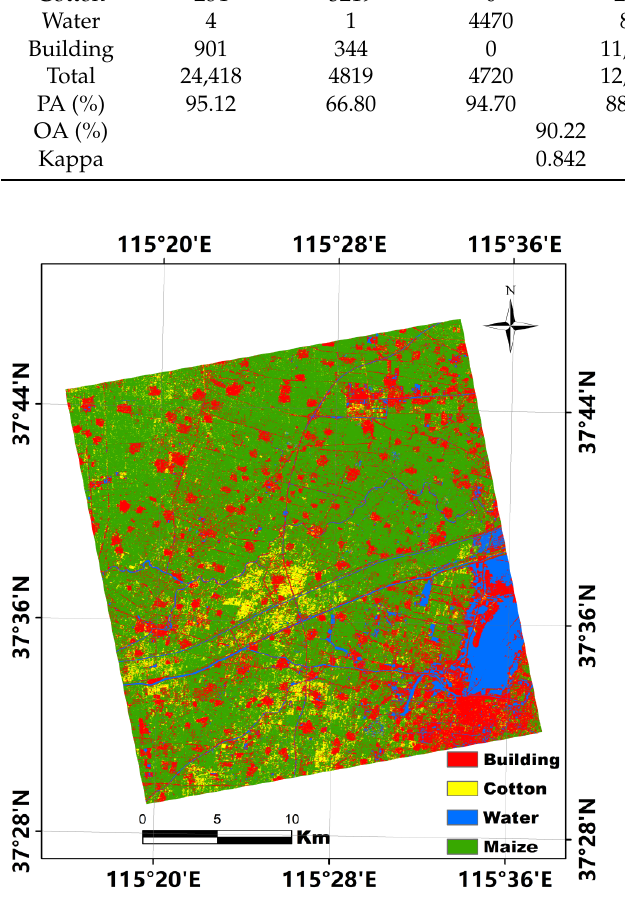
Figure 8. Classification map obtained using 11 features with 2 RADARSAT-2 images.